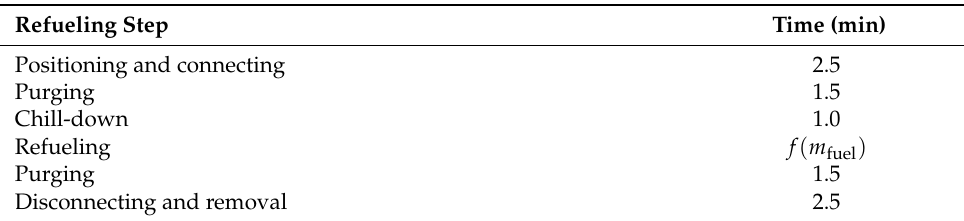
Table 2. Required time intervals for the individual consecutive steps of the refueling procedure of liquid hydrogen; time durations are independent of the refueled quantity, refueling time is a function of the required fuel mass or volume; the individual steps excluding refueling itself sum up to 9min for a Johnston disconnect and 6min for a clean break